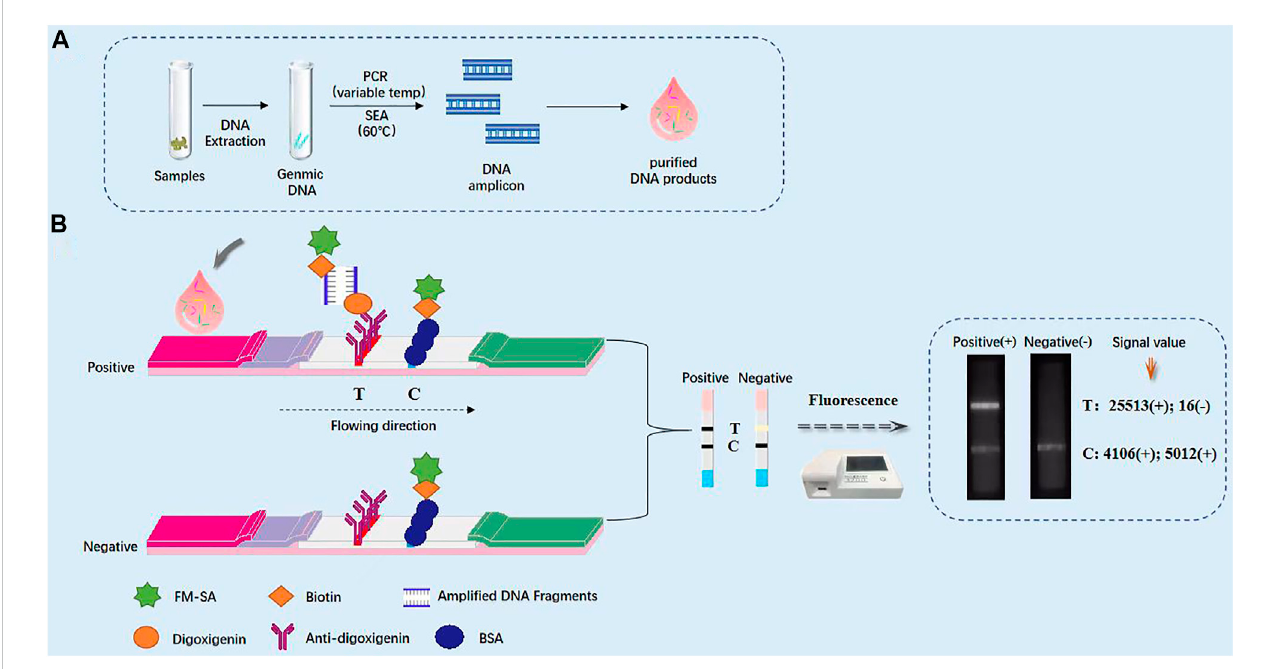
FIGURE 3 Schematic diagram of immunochromatographic test strip (ICTS). (A) Schematic diagram of immunochromatographic test strip for the detection of Klebsiella pneumoniae . (B) Photograph of the packaged ICTS and its internal structure, consisting of a sample pad, a conjugate pad, a detection region with test and control lines, and an absorbent pad.